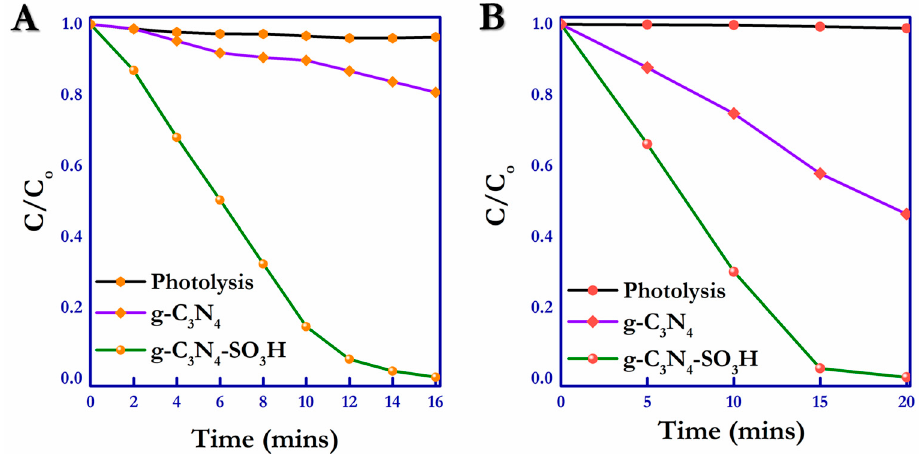
Figure 10. Photocatalytic effect of the g-C 3 N 4 and g-C 3 N 4 –SO 3 H materials on hexavalent Cr(VI) ( A ) and SSY species ( B ).